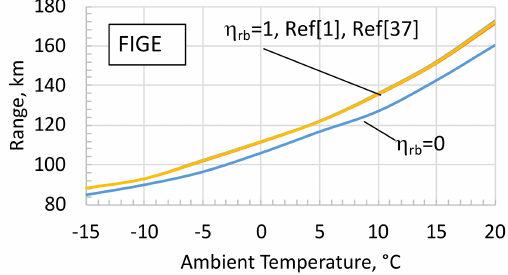
Figure 10. Impact of different regenerative braking assumptions on range in the case of FIGE driving cycle.